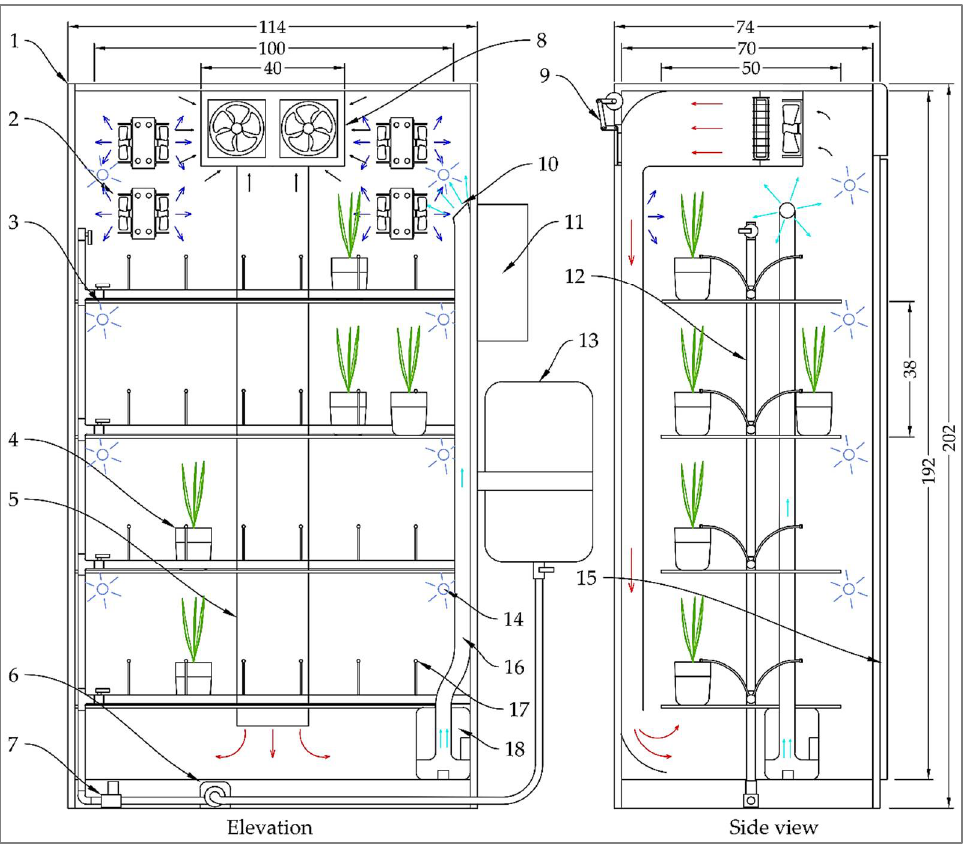
Figure 1. The elevation and side view of the ex vitro acclimatization system (E-VAS) components, all dimensions in centimeters. (1) The frame of the acclimatization chamber, (2) cooling unit (total number of cooling units was four), (3) plantlets shelves (total number of shelves was four), (4) plantlets pot (total number of pots was 48), (5) hot air duct, (6) water pump, (7) water solenoid valve, (8) heating unit, (9) ventilation gate, (10) outputted mist, (11) control unit, (12) main irrigation pipe, (13) water tank, (14) compact fluorescent light (CFL) bulb (total number of CFL bulbs was eight), (15) chamber door, (16) mist duct, (17) dripper (total number of drippers was 48), (18) ultrasonic humid- ifier.